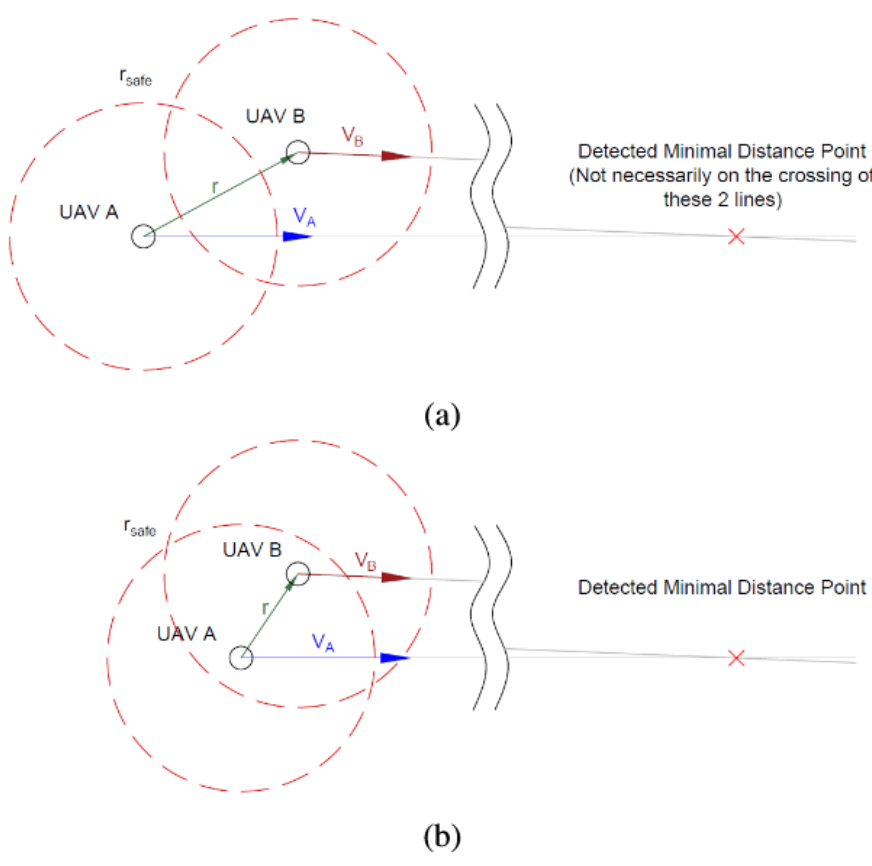
Figure 8. Example of the problematic situation after introduction of a collision time limit. ( a ) Detection of collision over a very long time, ( b ) safe area violation after a short